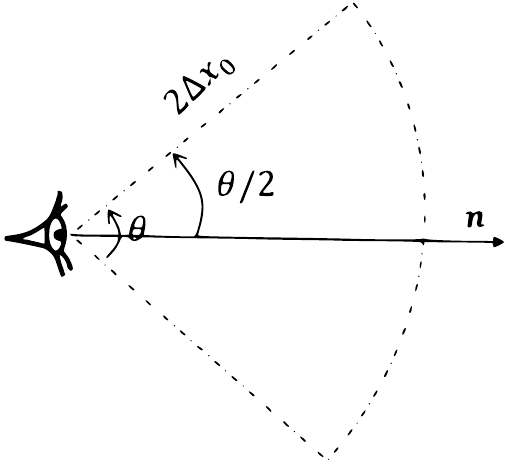
Figure 1. Free surface particle detection concept. θ is the angle of vision and 2 ∆ x 0 is the vision distance. Where ∆ x 0 denotes the initial particle spacing.